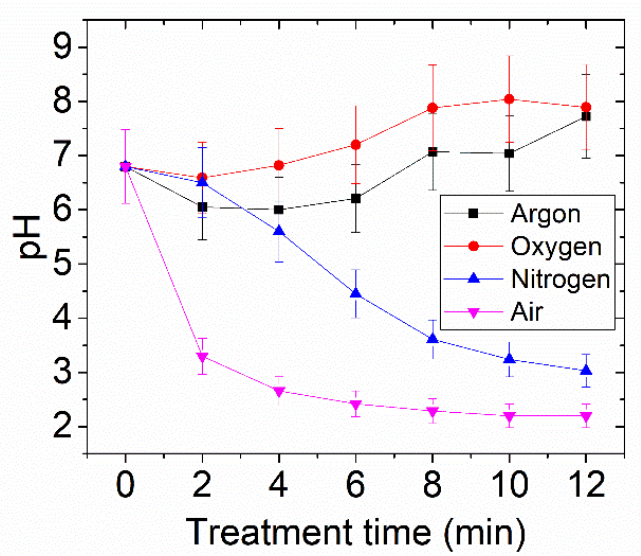
Figure 4. Variations of pH level for plasma-treated water as a function of time with four gas feedings: argon, oxygen, nitrogen, and air.